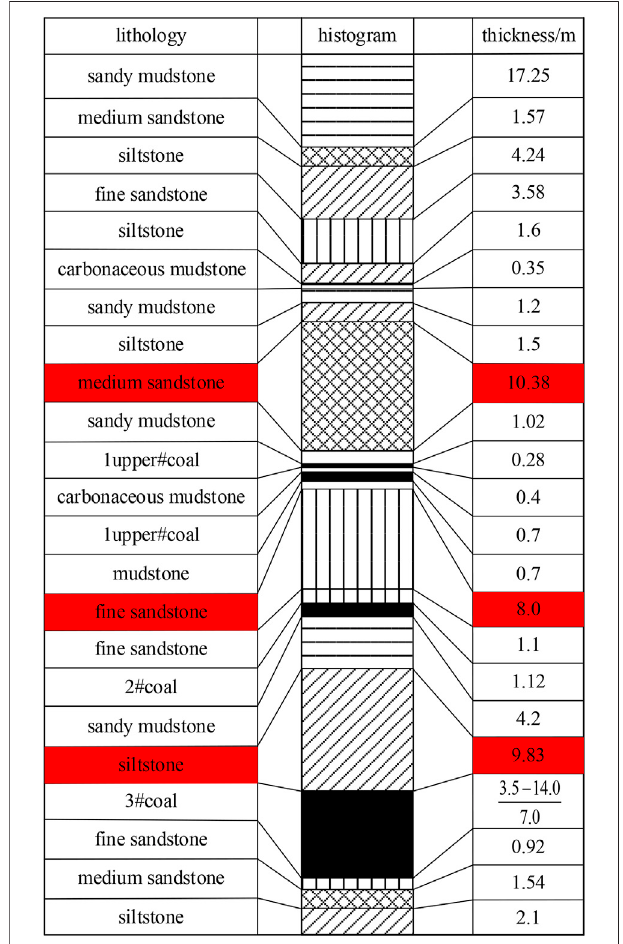
FIGURE 1 | Comprehensive histogram of rock